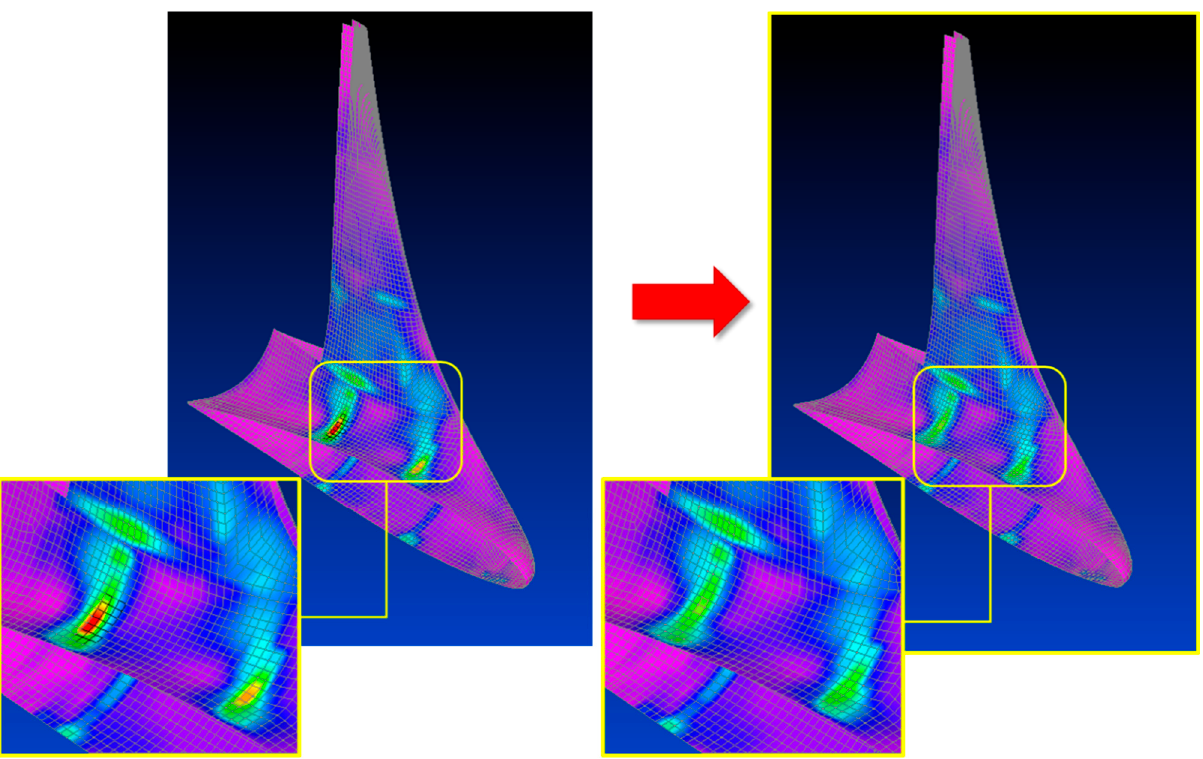
Figure 9. Normalized stress for the original configuration, RL, ( left ) and the one integrated with the additional beam ( right ); normalization reference: maximum stress computed on the distribution reported in Figure 4 (RL).